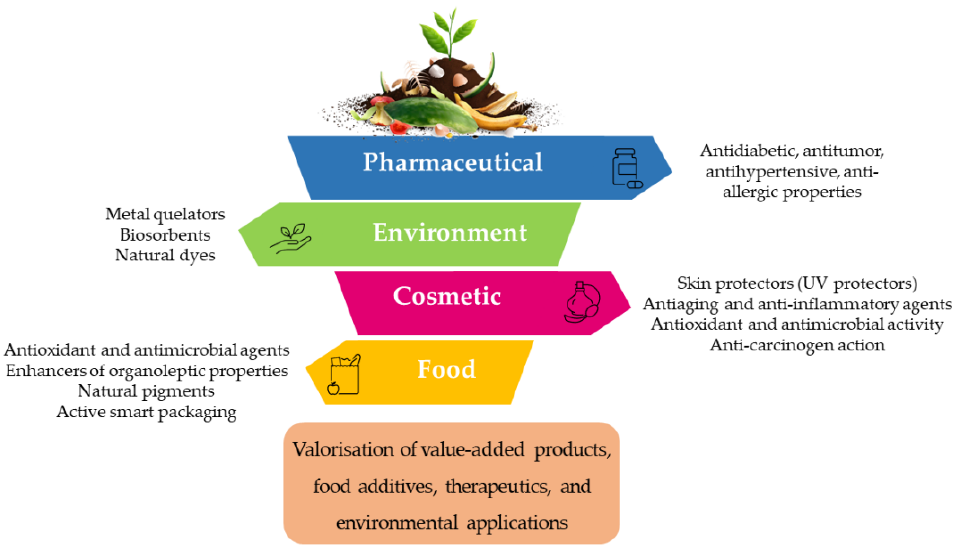
Figure 4. Overview of the main fields of application in which bioactive compounds recovered from food wastes can be applied.